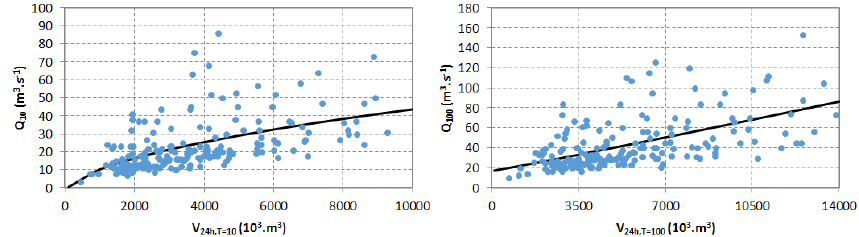
Figure 9. Relationship between catchment 24h precipitation volume and peak discharge value for T = 10 years (left panel) and T = 100 years (right panel) with fitted lines following Eq.